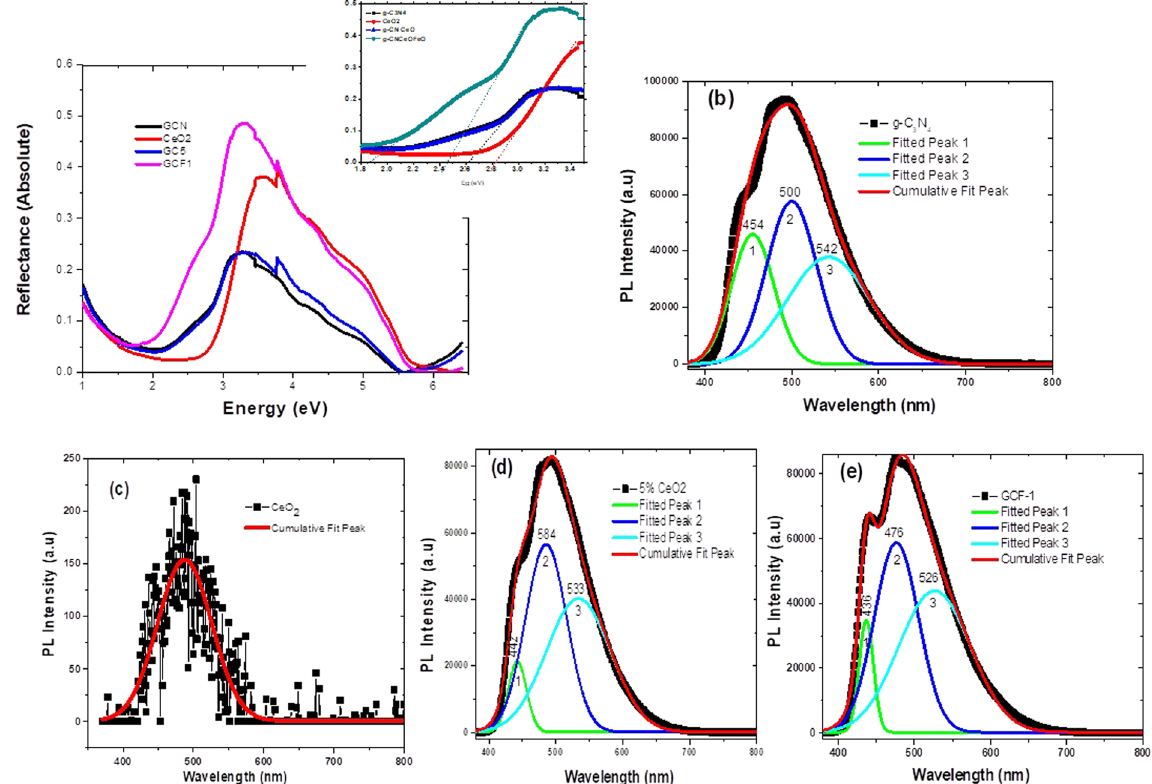
( d) binary composite g-C 3 N 4 /CeO 2 nanosheets. ( e) Ternary composites of g-C 3 N 4 /CeO 2 /Fe 3 O 4